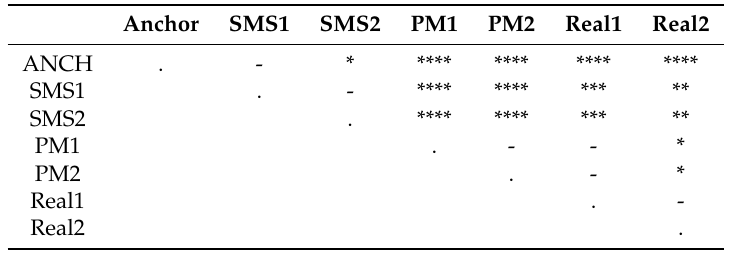
Table 7. The effect of different sample for a wooden sword (**** ⇒ p < 0.0001, *** ⇒ p < 0.001, ** ⇒ p < 0.01, * ⇒ p < 0.05, - ⇒ p ≥ 0.05). SMS, spectral modelling synthesis; PM, physical model; Real, recorded sample.